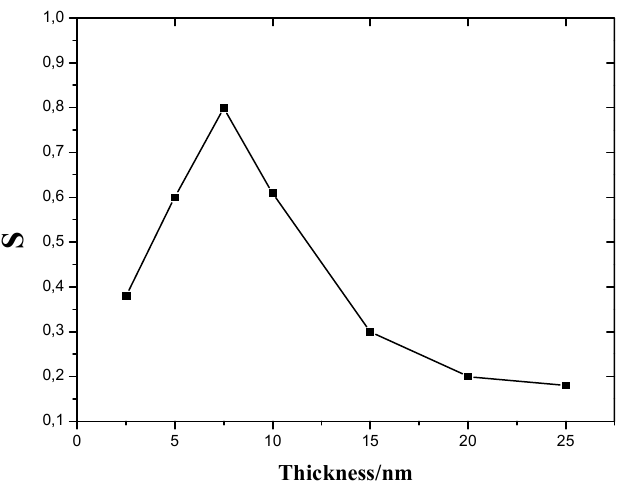
Figure 1. The sensitivity of various metal oxided-loaded SnO function of the electronegativity (Xi) of the metal cations.